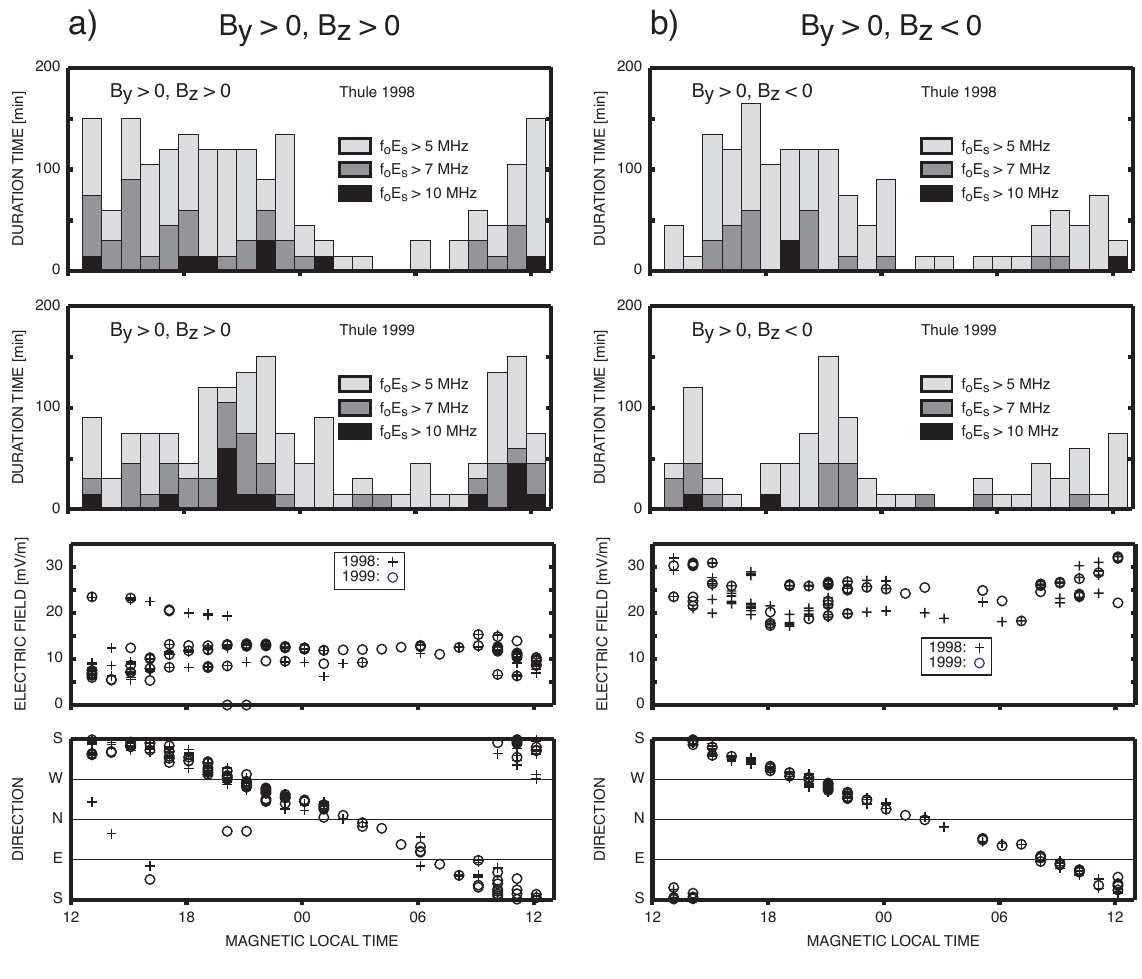
Fig. 7. (a, b) Same as Figs. 6a, b in 1998–1999 at